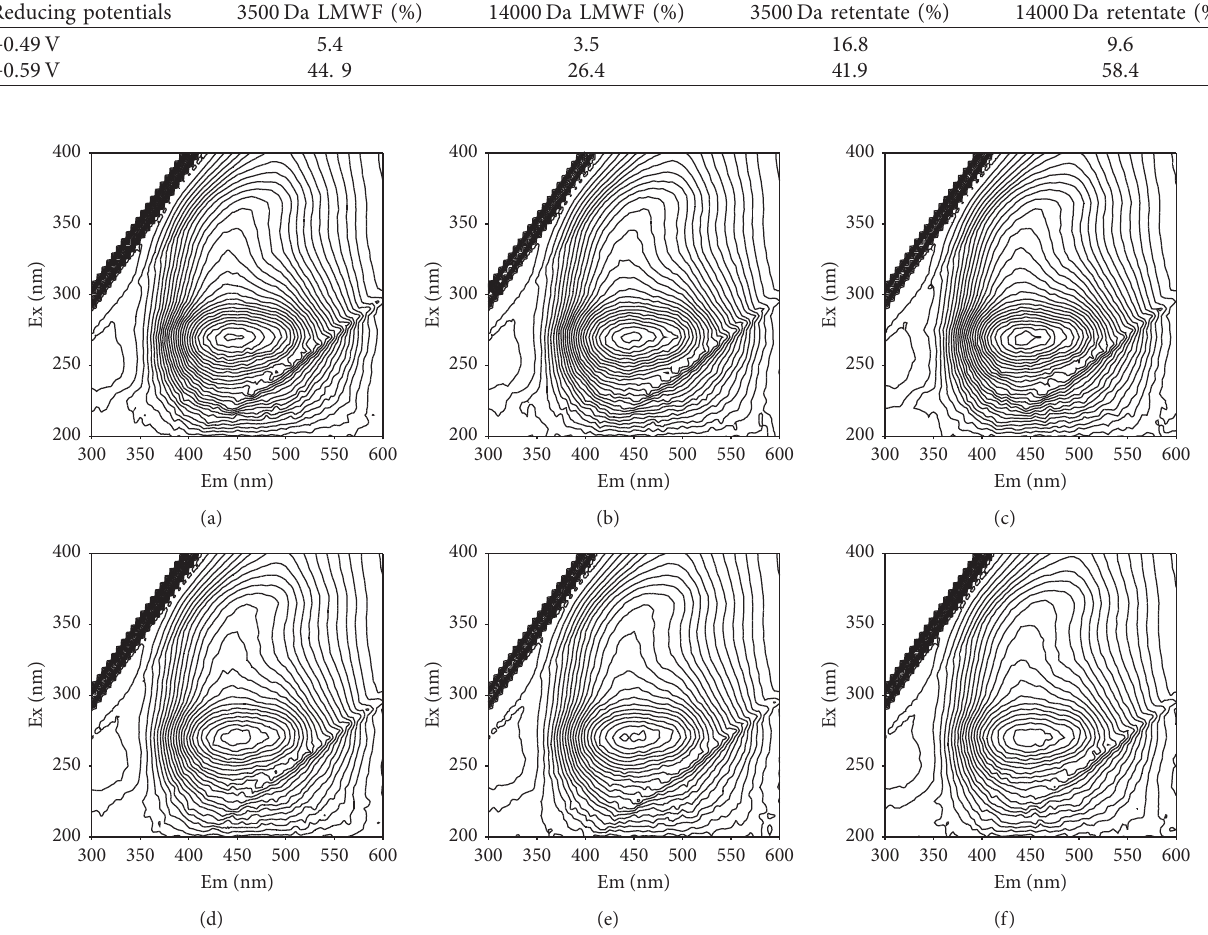
Figure 4: 3DEEM fluorescence spectra of LMWF of LNOM in their native, after − 0.49V and − 0.59V DER redox state: (a) 3500 LMWF native; (b) 3500 LMWF − 0.49V; (c) 3500 LMWF − 0.59V; (d) 14000 LMWF native; (e) 14000 LMWF − 0.49V; (f) 14000 LMWF − 0.59V. Table 3: Fluorescence peak positions and relative fluorescence intensities of LMWF of LNOM in different redox states. Samples Native